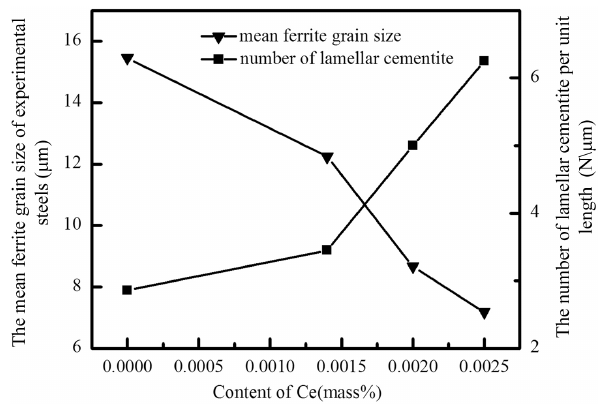
Figure 3: The change of mean ferrite grain size and pearlite lamella spacing with content of Ce.